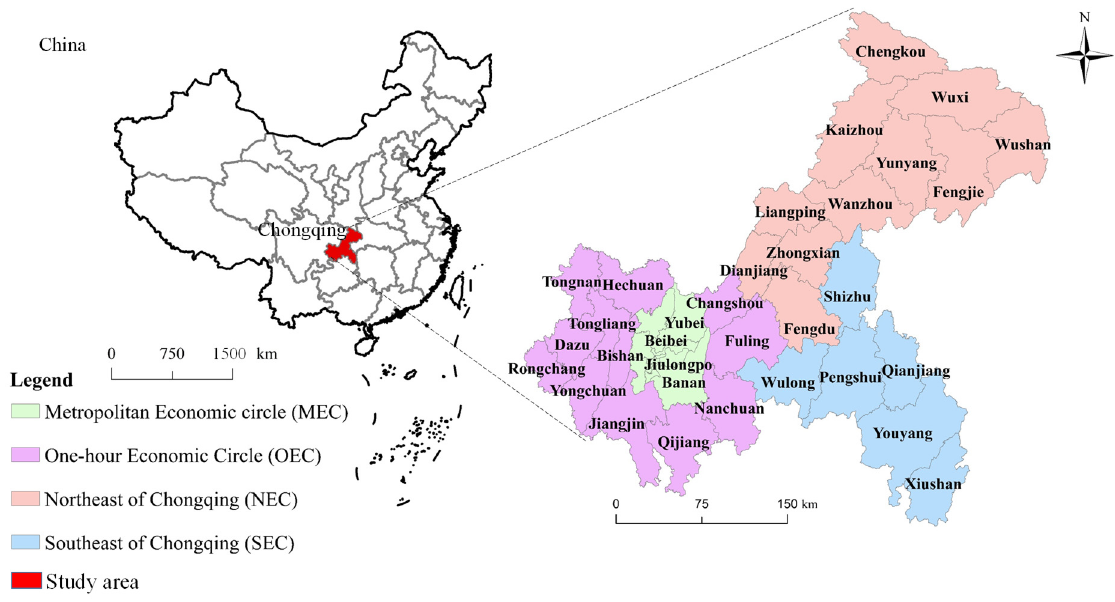
Figure 1. Location of the study